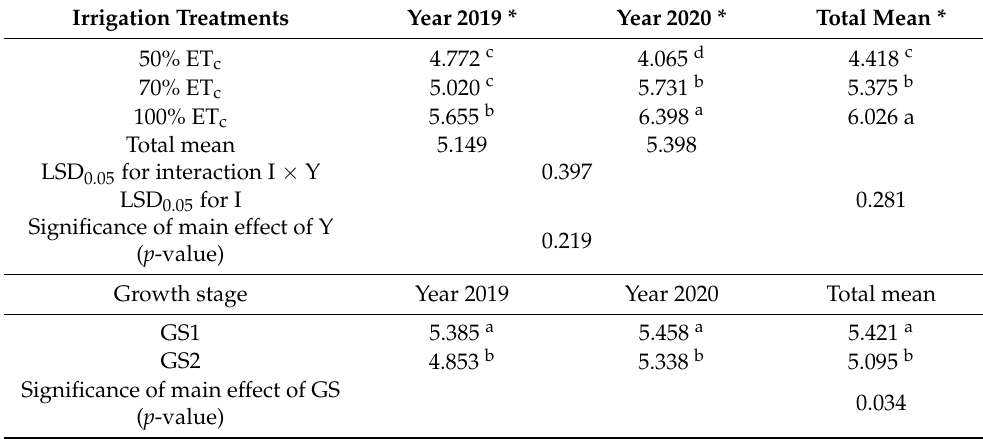
Table 7. CO 2 assimilation rate (A) for the two years 2019 and 2020, for two growth stages. Data presented are mean values, where LSD 0.05 is the Least Significant Difference at the 0.05 significance